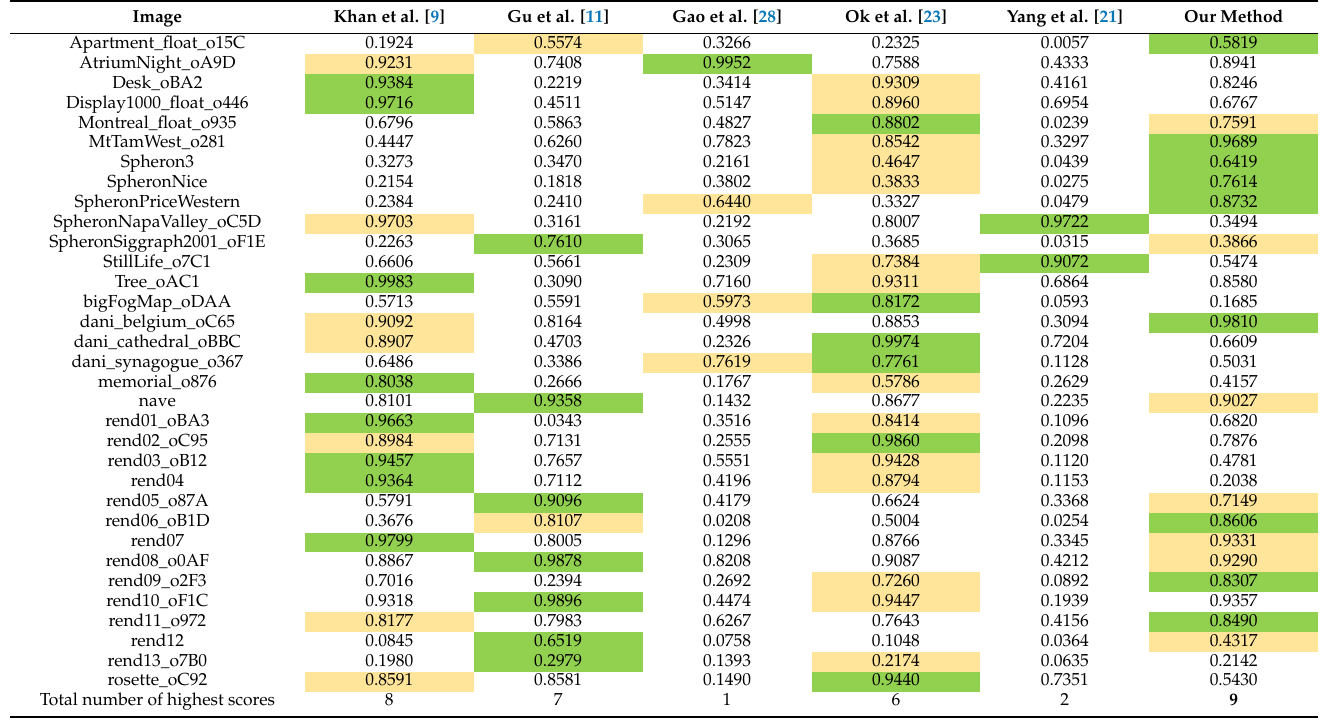
Green (and Yellow) numbers indicate the best (and the second-best) performing methods for each row, respectively. Table 4. TMQI-Q score of images from the dataset in [29] and total number of highest scores for each method. Image